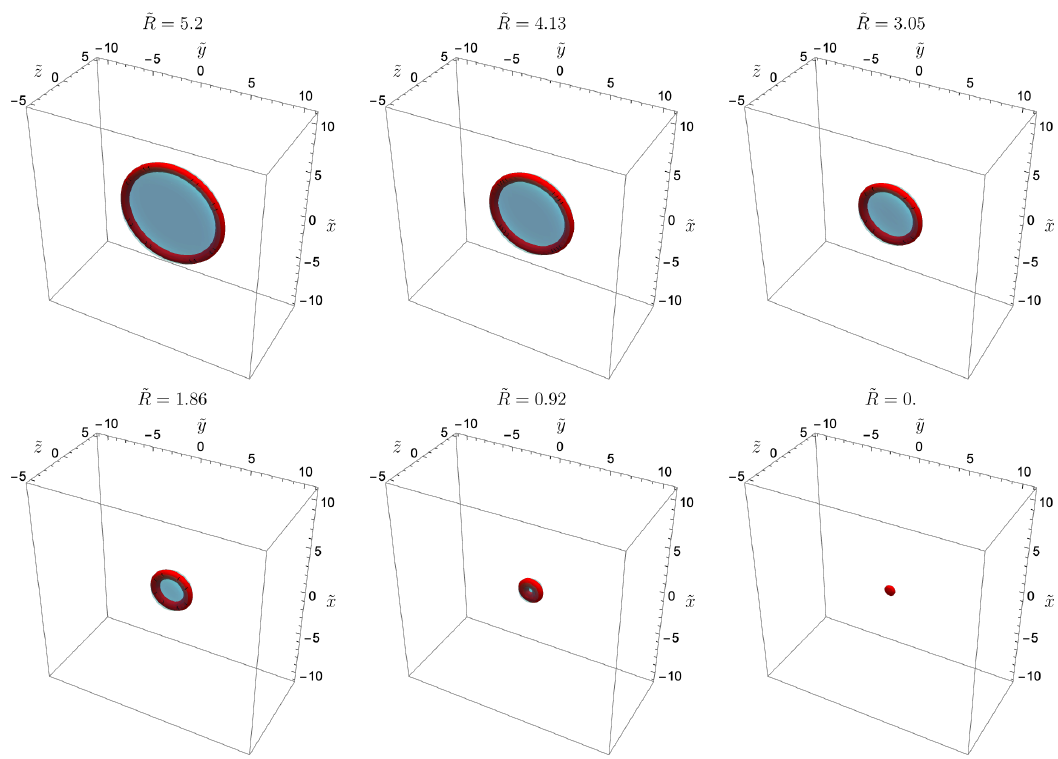
Figure 5 . The disk soliton bounded by a ring string. The red part shows the region for | ˜ φ | < 0 . 9 , and the blurred-blue part corresponds to the region for Re[˜ φ ] < 0 . 4